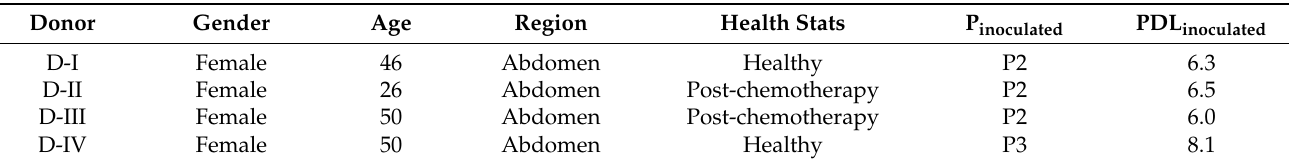
Table 1. Overview of donor-related data. The passage number and population doubling level (PDL) refer to the cell inoculum used for the growth